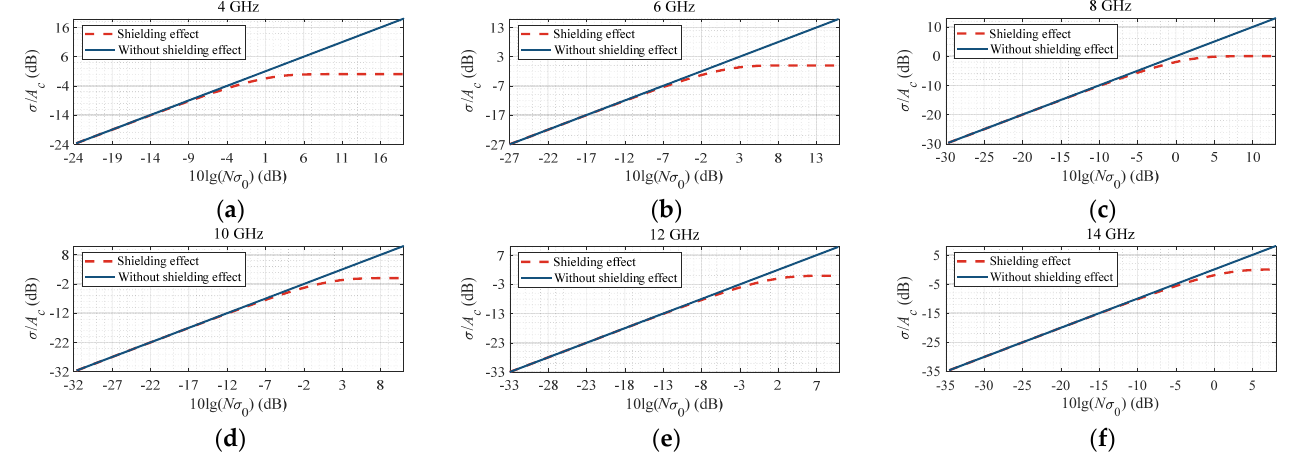
Figure 6. Chaff shielding effect curves for different incident wave frequencies. ( a ) 4 GHz; ( b ) 6 GHz; ( c ) 8 GHz; ( d ) 10 GHz; ( e ) 12 GHz; ( f ) 14 GHz. One opposite face of the voxel needs to be perpendicular to the incident wave when calculating the RCS of the chaff voxel. Chaff coordinates can be rotated to the same or opposite direction of the z ‐ axis and the incoming wave direction (red line) using coordi ‐ nate rotation, as shown in Figure 7, so that the edge of the voxel can be parallel to the coordinate system vector during segmentation. be obtained by rotating counterclockwise. The rotation matrix is indicated in (19). And the rotation coordinates can be calculated according to the equation (20).